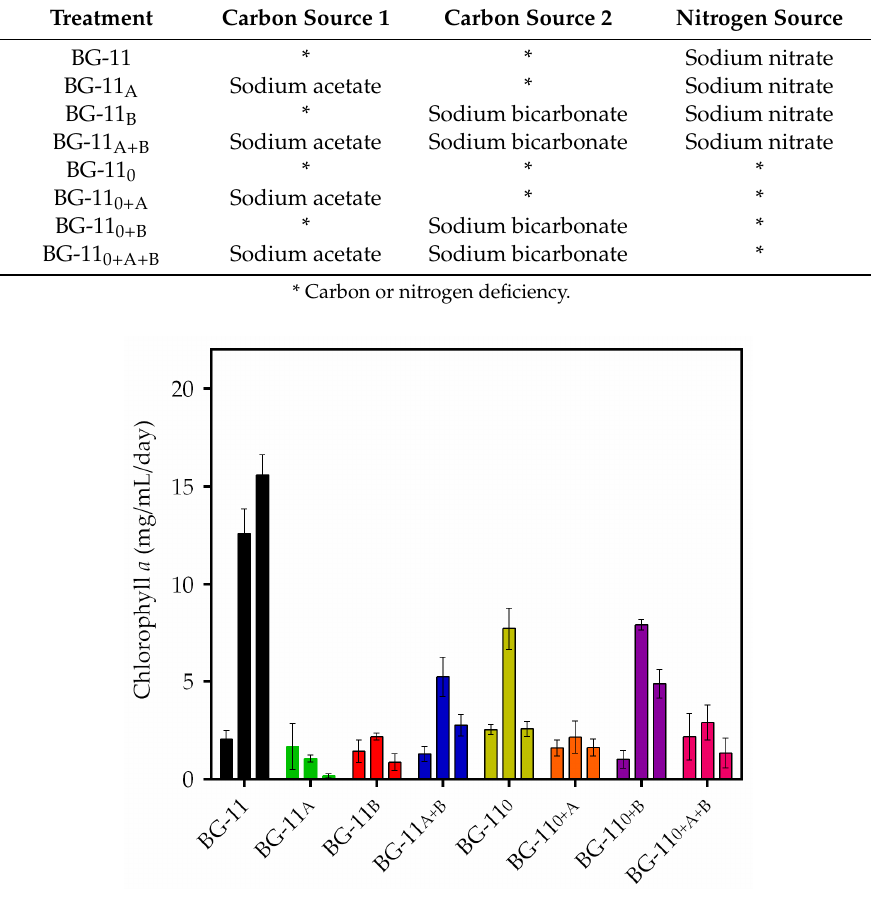
Figure 3. Chlorophyll a concentration (mg / mL / day) of the Stigeoclonium sp. B23 in eight culture conditions. Three time points were plotted in each cultivation: the left bar corresponds to day 0 of the cultivation, the middle bar corresponds to day 15, and the right bar to day 30. Data are the mean ± SD of three replicates.